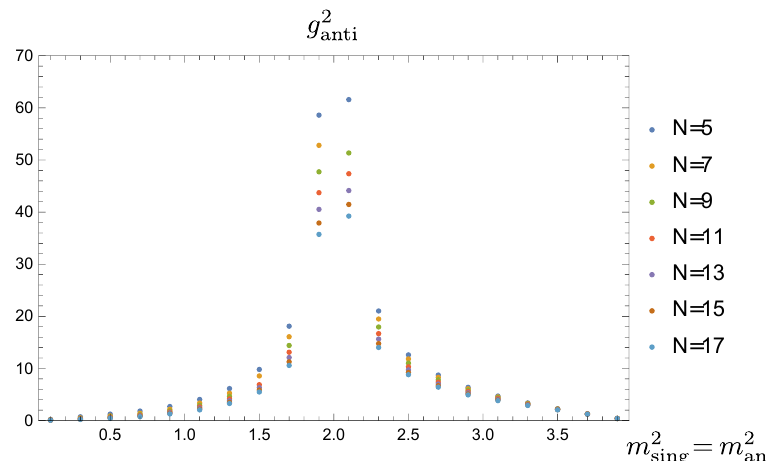
Figure 10 . Maximum couplings obtained numerically for the case of one bound state in the anti- symmetric representation and another one in the anti-symmetric representation with equal